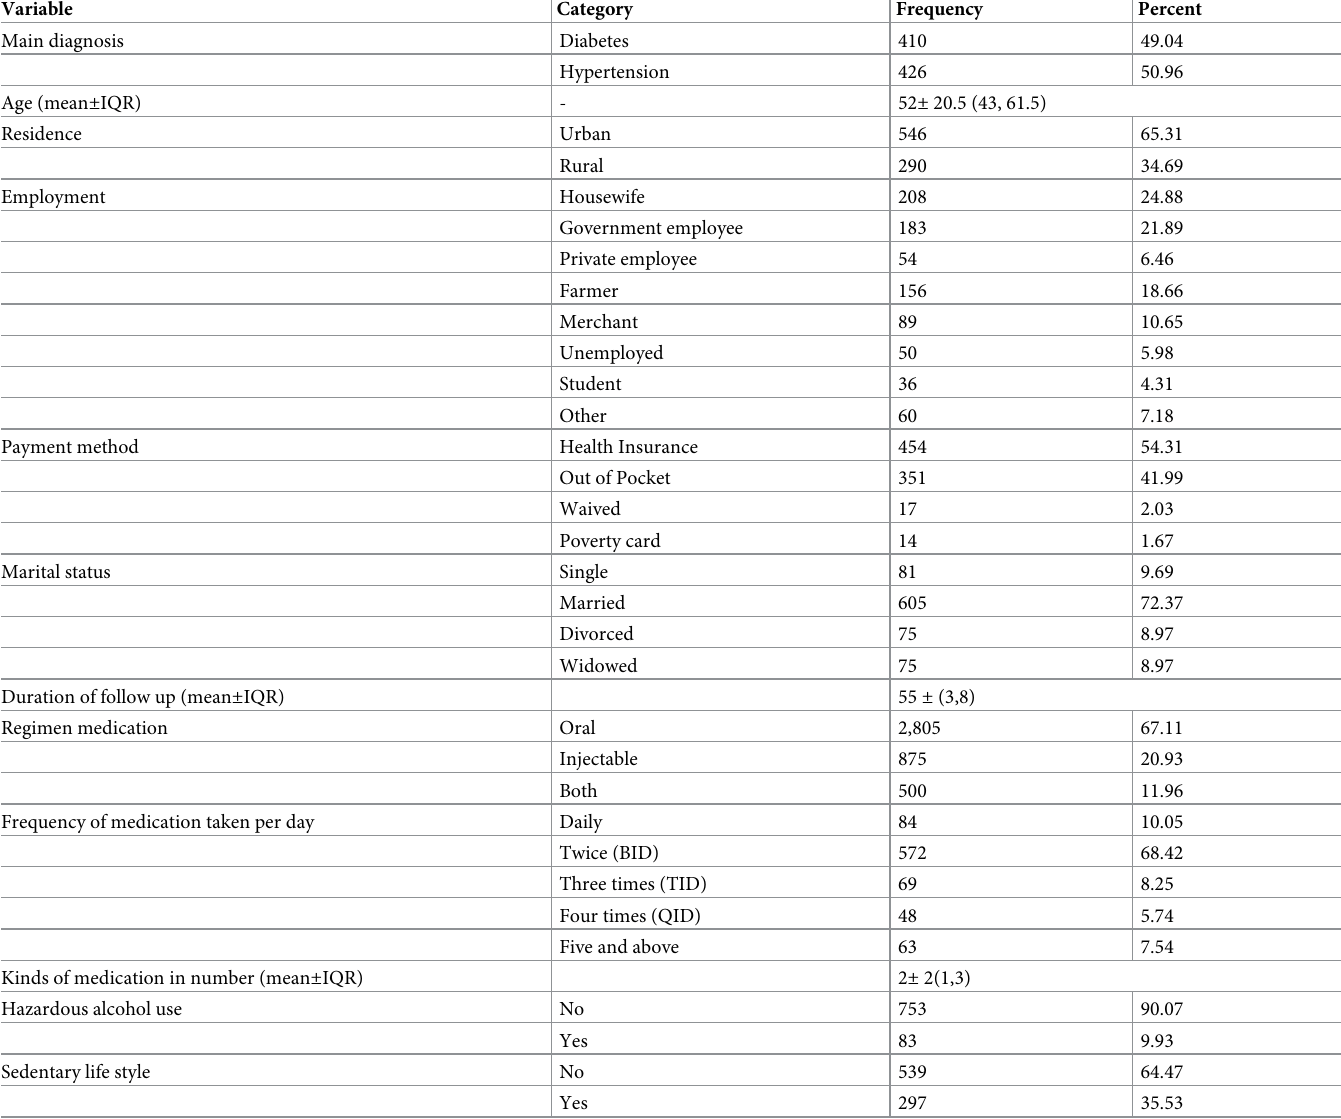
Table 1. Background characteristics of Diabetic and/ or Hypertensive patients in Northwest Ethiopia, 2021 (n = 836). Variable Main